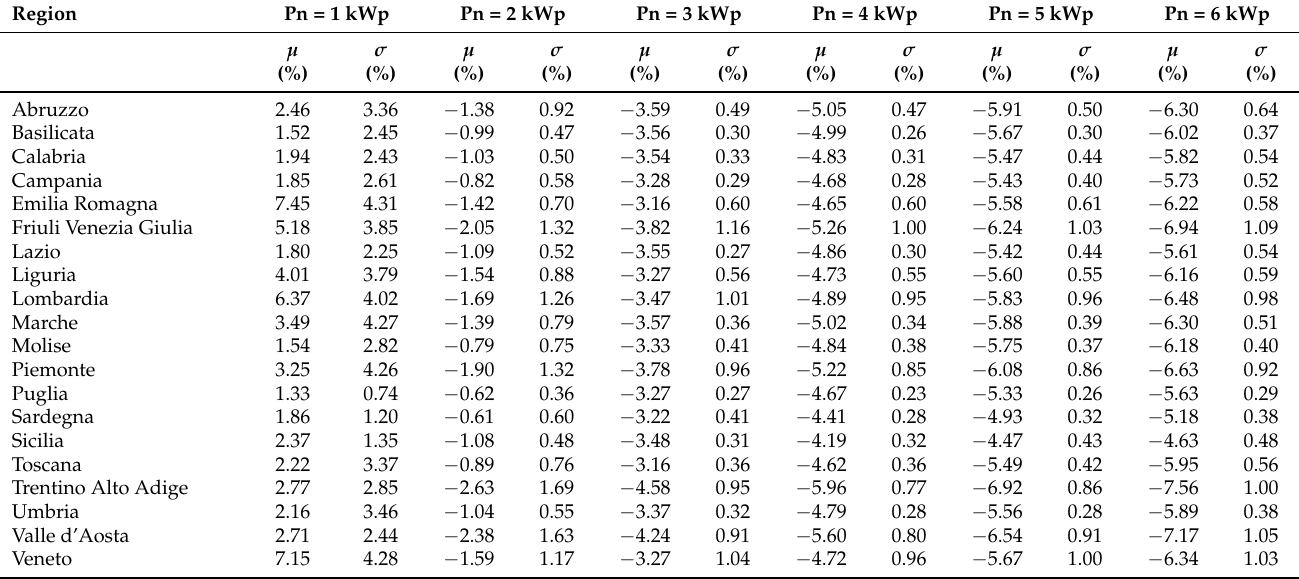
Table 14. IRR E L = 2700 kWh with battery.